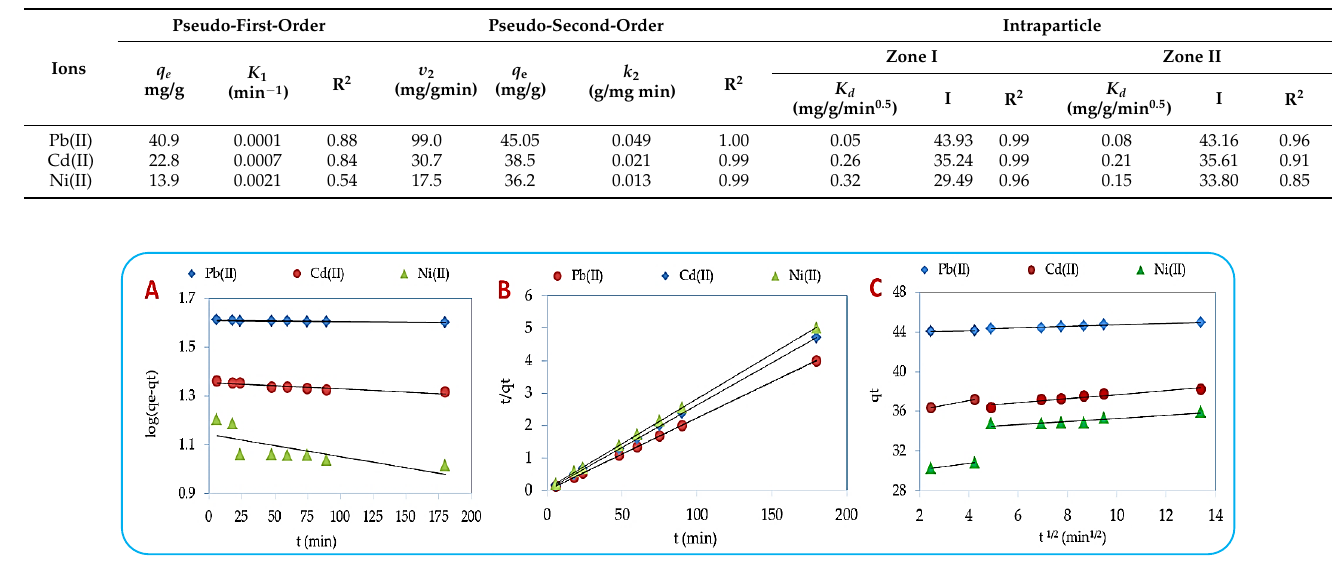
Figure 4. Plot of pseudo-first order equation ( A ), pseudo-second order equation ( B ), and intraparticle ( C ) of Cd(II), Pb(II), and Ni(II) ions’ adsorption by S. cerevisiae biomass.